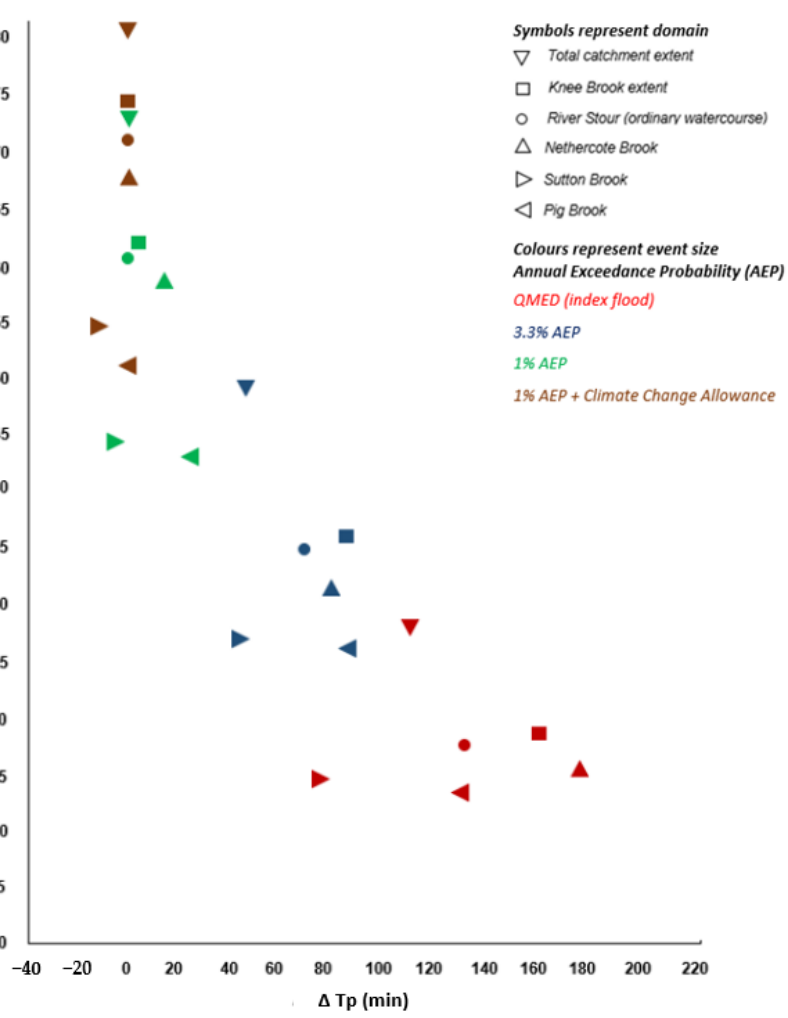
Figure 9. Change ( Δ ) in time-to-peak (Tp) across modelled domains at varying hydrological scales, where Q = discharge.